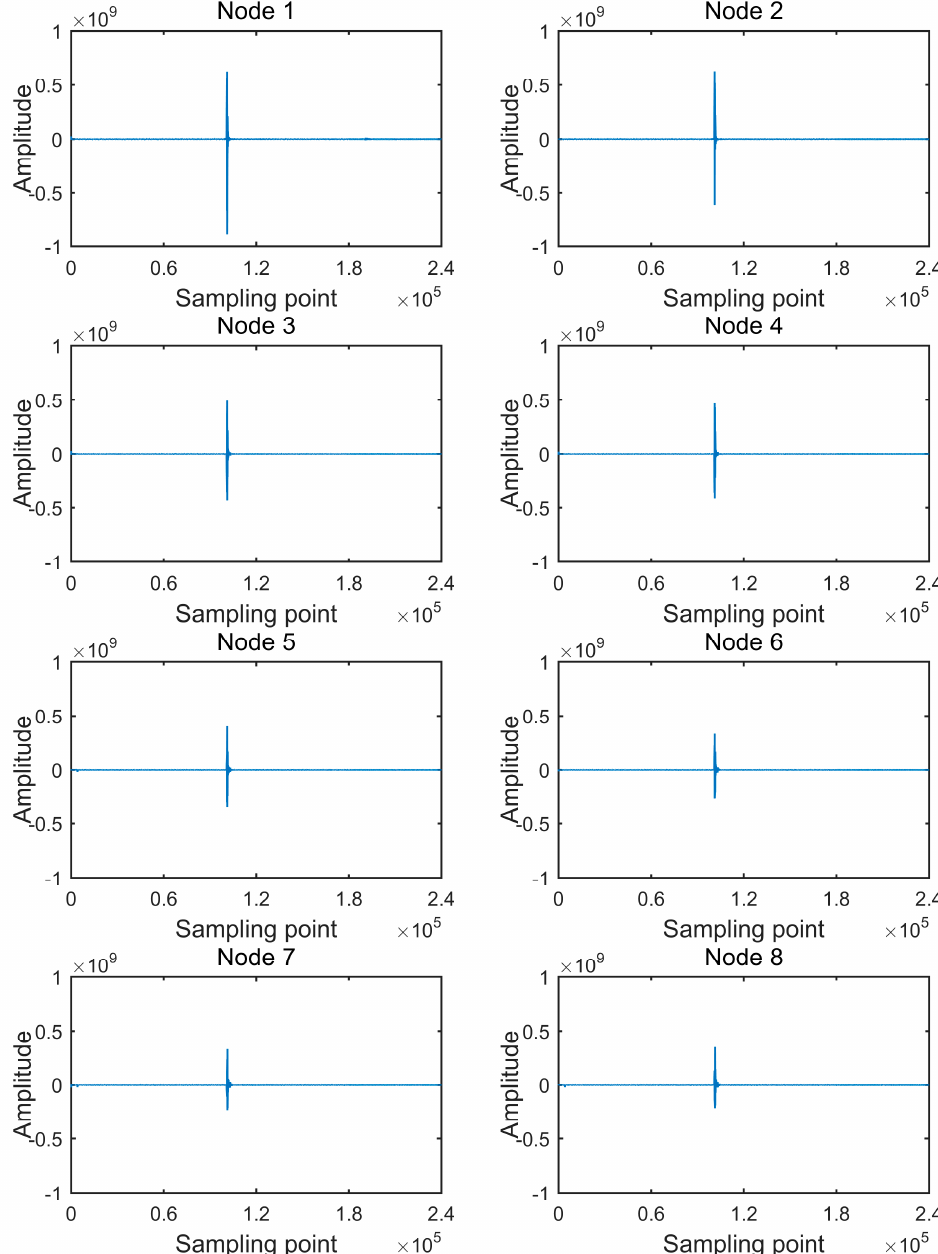
Figure 9. Waveforms of received